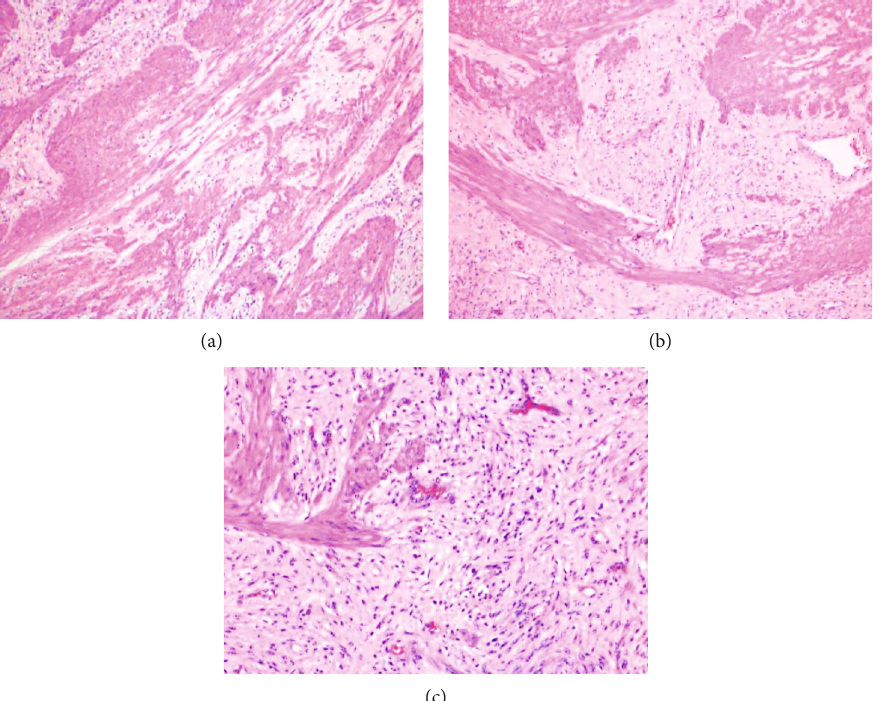
Figure 3: (a) Low-power magni fi cation featuring bundles of smooth muscle fi bers with intervening vascularized myxoid tumor, forming a plexiform pattern (H&E × 40). (b) Low-power magni fi cation featuring myxoid vascularized areas alternating with cellular bundles of smooth muscle fi bers (H&E × 40). (c) Spindle-shaped cells free of atypia or mitotic activity within myxoid stroma (H&E × 100).